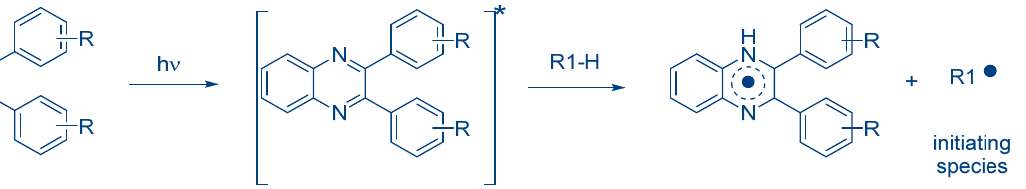
Scheme 5. Mechanism involved in the polymerization process using quinoxalines as the photosensi- tizers. (* corresponds to the excited